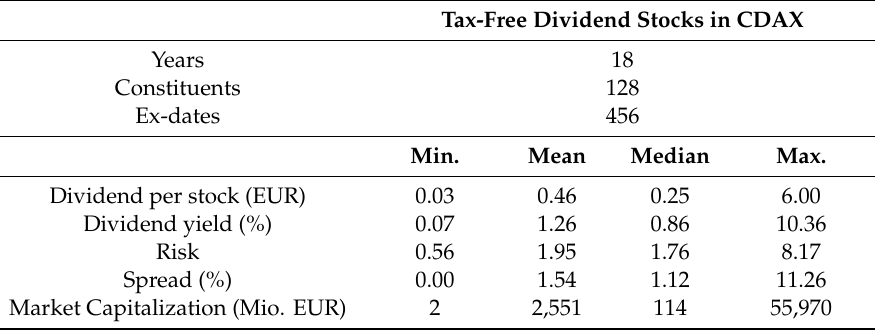
Table 1. Summary